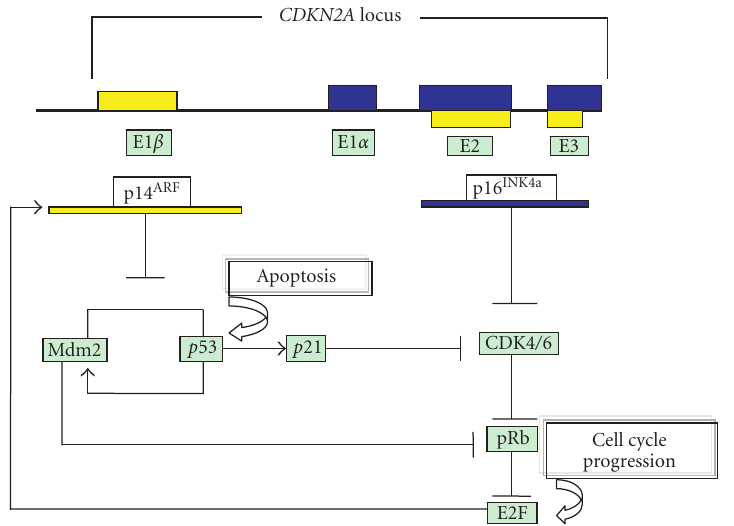
Figure 2: Genomic organization of the CDKN2A locus and description of involvement of its transcripts (p16 INK4a and p14 ARF ) in the Rb and p53 pathways. p16 INK4a /CDK4/pRb pathway: CDK 4 negatively regulates pRb protein activity by phosphorylation. p16 INK4a inhibits CDK4 binding to cyclin D preventing inactivation of pRb. Hypophosphorylated pRb represses E2F-dependent genes blocking G1/S cell cycle progression. p14 ARF /p53 pathway: p53 is targeted by MDM2 for ubiquitination and degradation. In response to oncogenic signals, p14